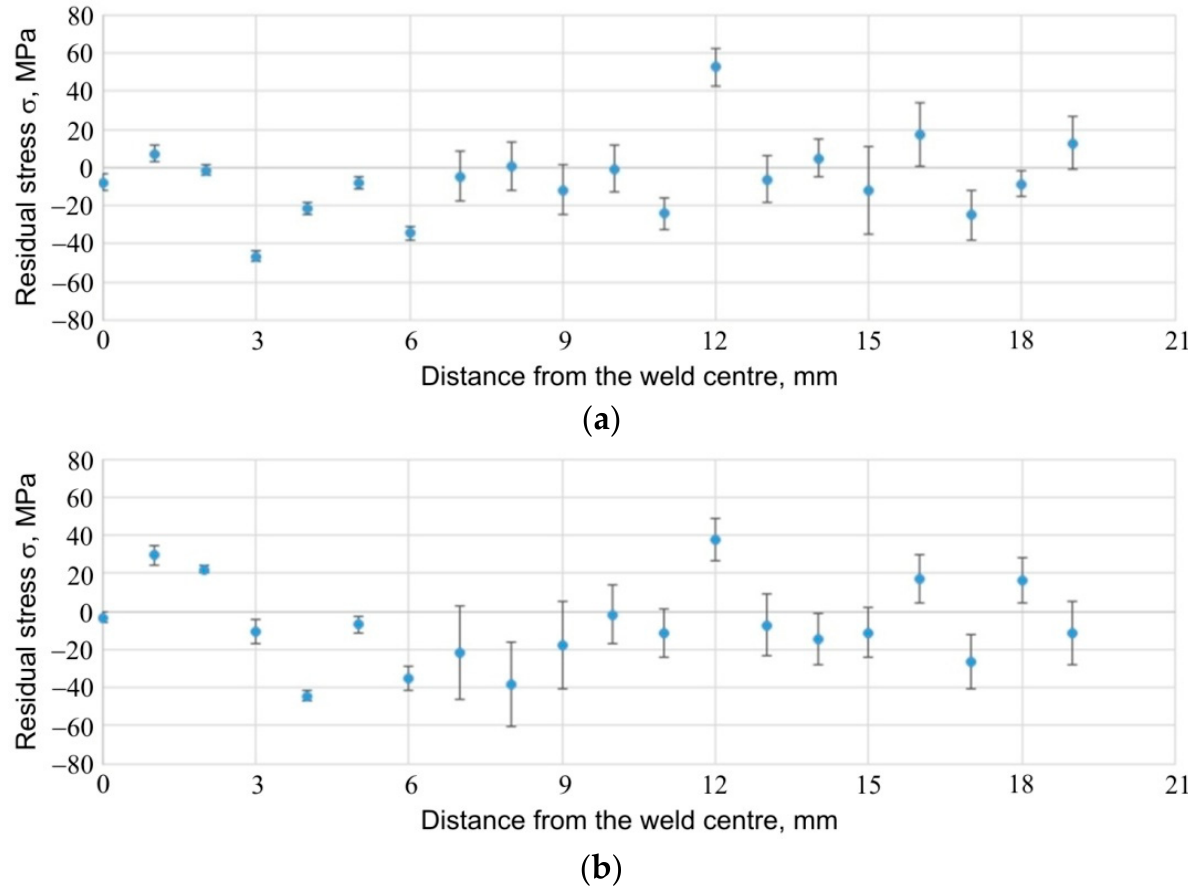
Figure 28. Stresses present in and around the RFSSW joint for specimen E6, for 1.6 mm thick sheet; ( a ) tangential and ( b ) radial component of stresses.